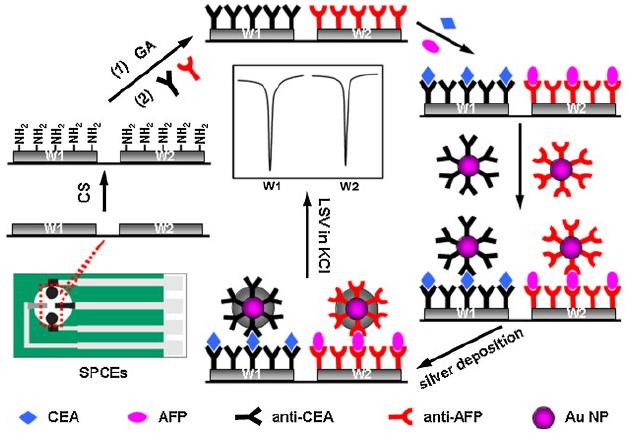
Figure 4. Schematic of the electrochemical immunosensor array and detection strategy by linear- sweep stripping voltammetric analysis of Ag NPs catalytically deposited on the immunosensor sur- face by gold nanolabels (reprinted with permission from Ref. [71], Copyright 2012, Elsevier).